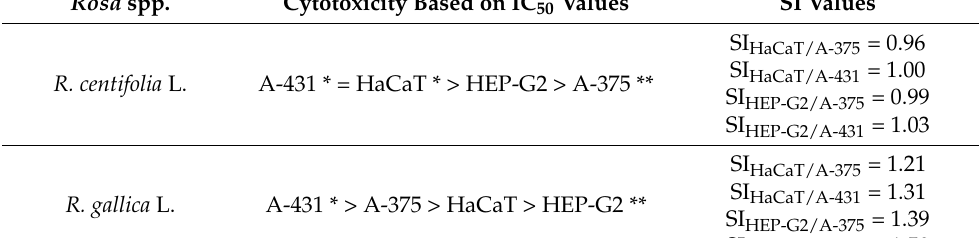
Table 4. Comparison of the cytotoxicity of wastewaters obtained from four different rose species on non-tumorigenic and tumorigenic cell lines, based on selectivity index values. Rosa